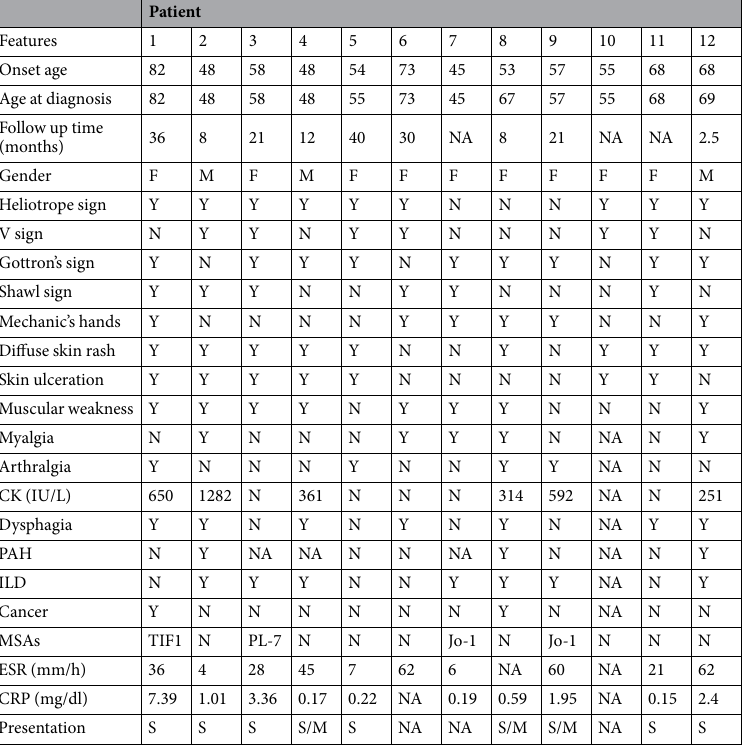
Table 1. Clinical features of DM patients with anti-SAE antibodies. NA, not available; CK, creatine kinase; PAH, pulmonary arterial hypertension; ILD, interstitial lung disease; CRP, C-reactive protein; ESR, erythrocyte sedimentation rate; MSAs, myositis-specific autoantibodies; MAAs, myositis-associated autoantibodies; S, initially presented with skin disease only; S/M, presented with skin and muscular